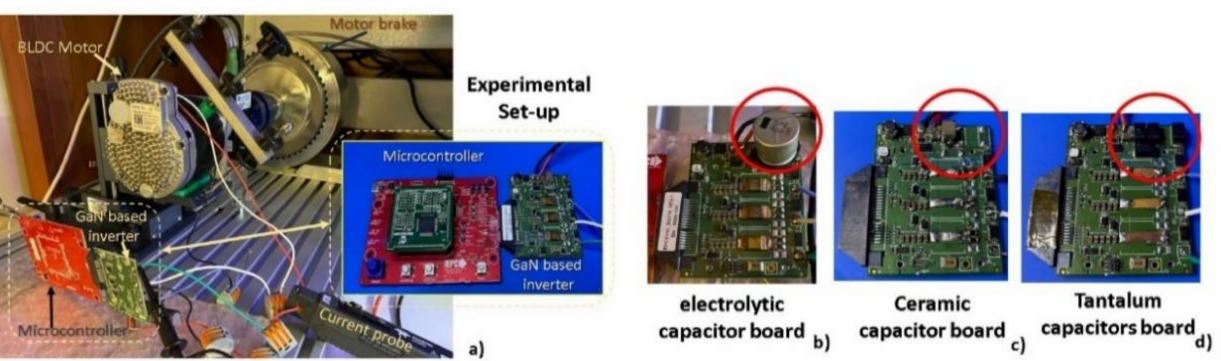
Figure 11. ( a ) Picture of the experimental set-up with a zoomed view of the microcontroller and GaN FET based inverter. ( b ) Inverter board with electrolytic capacitor filter. ( c ) Inverter board with ceramic capacitor filter. ( d ) Inverter board with tantalum capacitor filter.